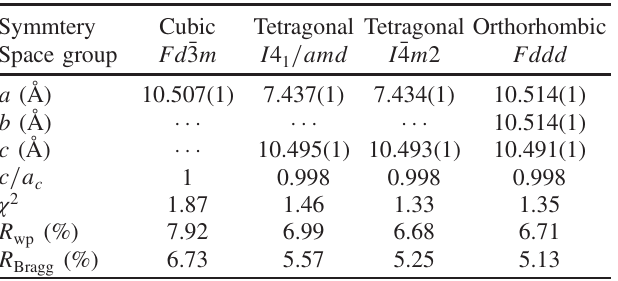
TABLE V. Candidate crystal structures for FeSc 2 S 4 at 20 K.